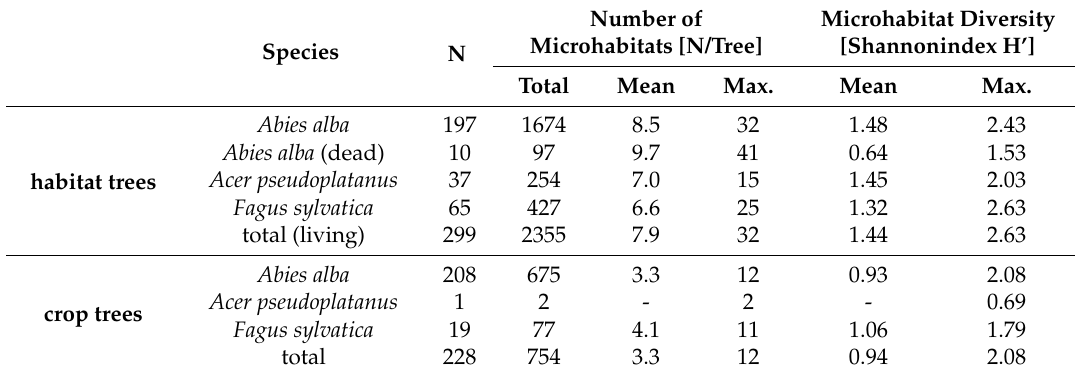
Table 3. Number and diversity of microhabitats in habitat and crop